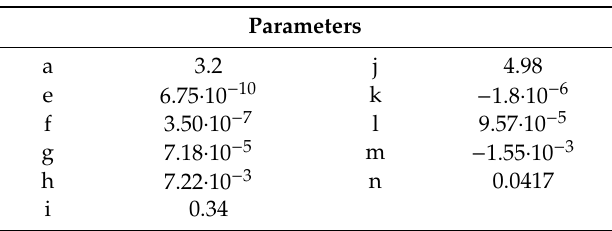
Table 1. ParameterAtion